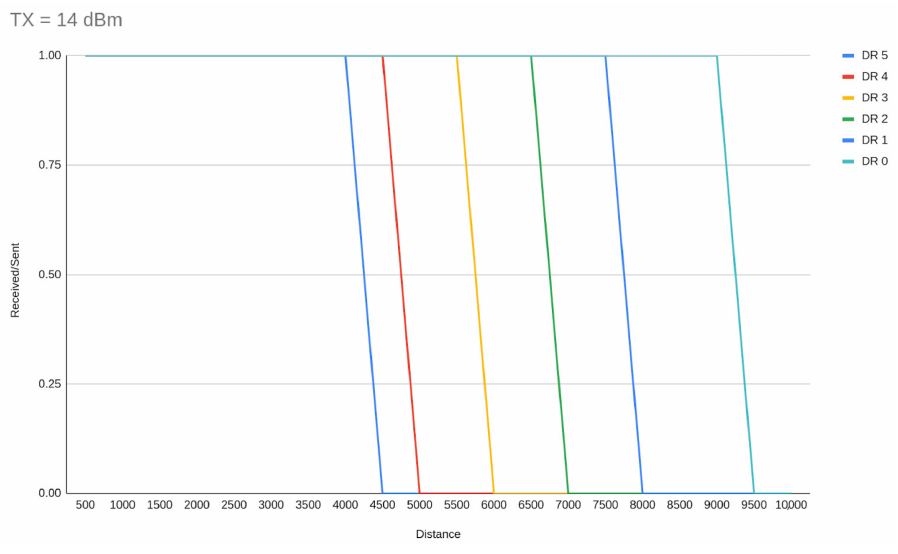
Figure 10. Range of communication with TX power of 14